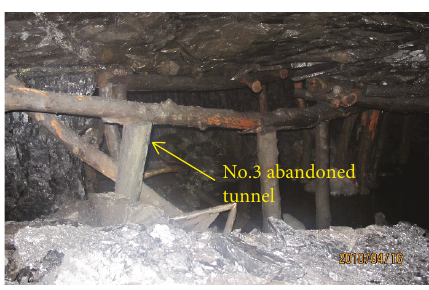
Figure 13: No.3 abandoned tunnel.